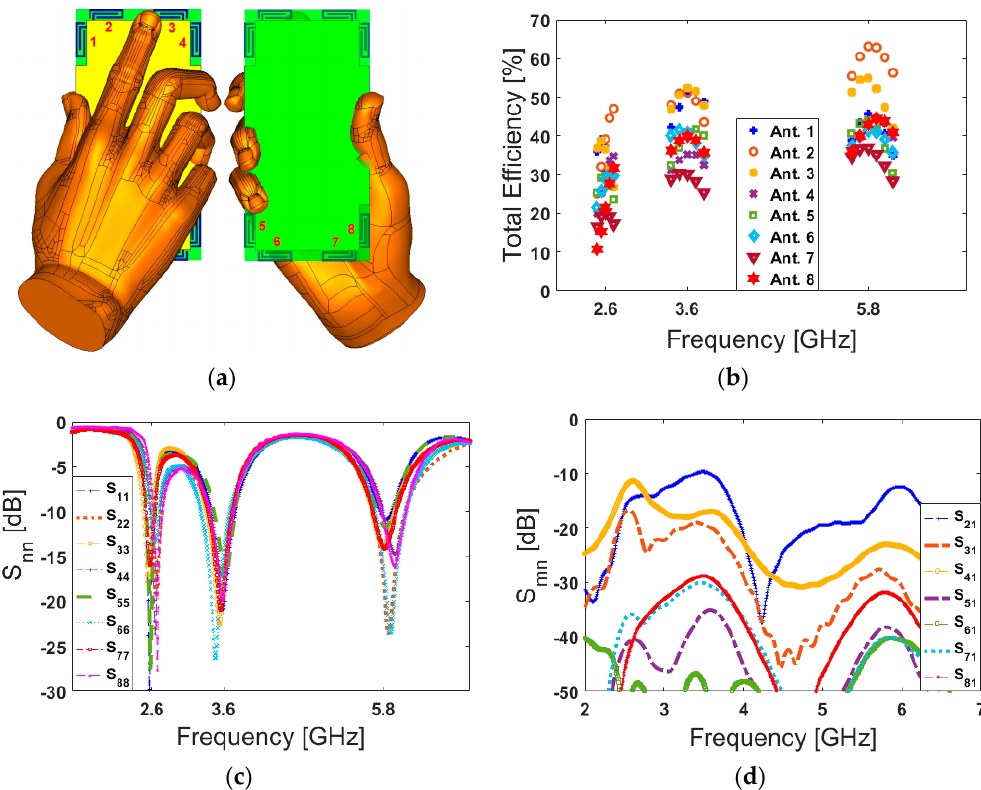
Figure 14. ( a ) Placement, ( b ) total efficiencies, ( c ) S nn , and ( d ) S mn results for the right-hand scenario.